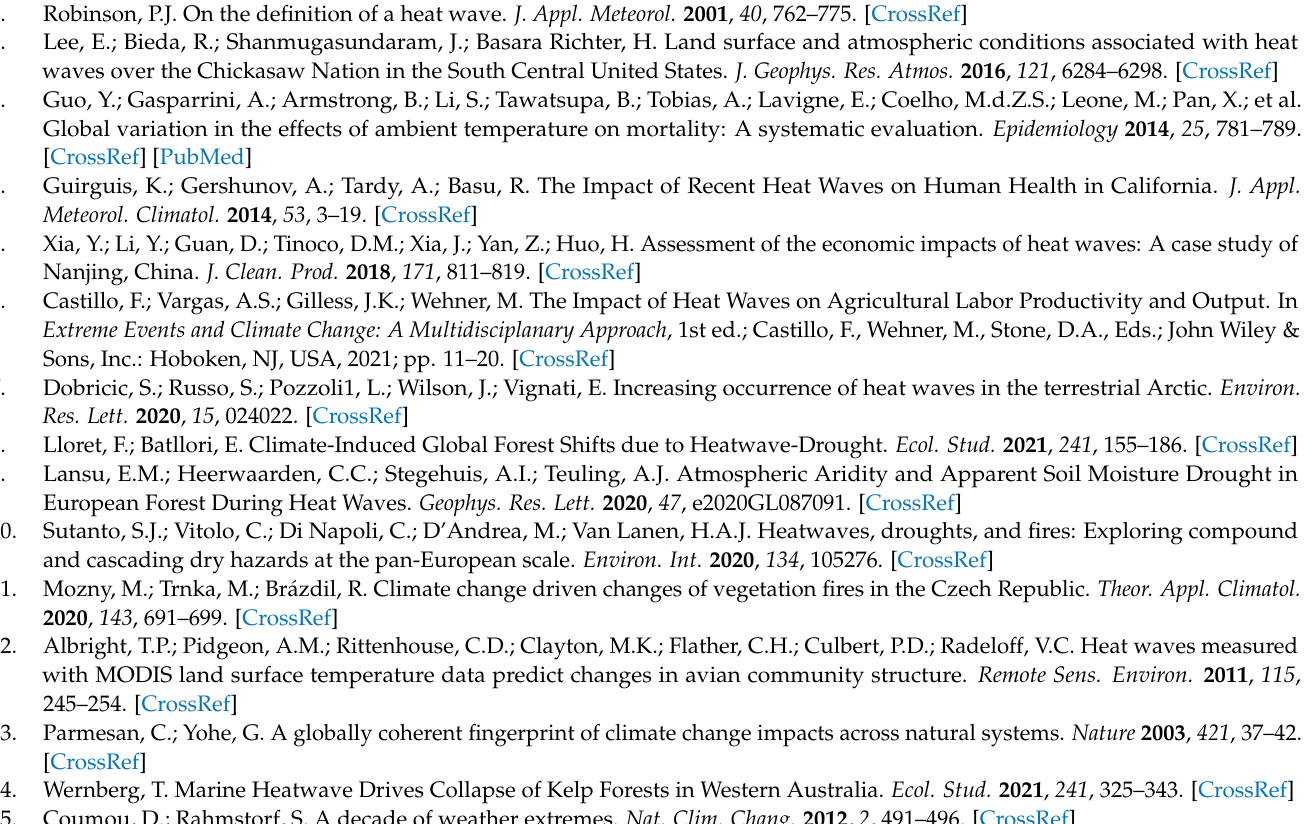
Table S2. Specifications of Landsat 8 data used in the analysis; Table S3. Comparison between SUHI intensities using MODIS (daytime) and Landsat 8 data; Table S4. Results of Global Mora’s I and Geary’s C for the sampled of 18 cities and towns